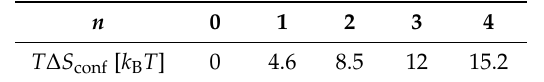
Table 1. Dependence of the configurational entropy contribution of the vacancies and interstitials (in k B T units) on the number ( n ) of point